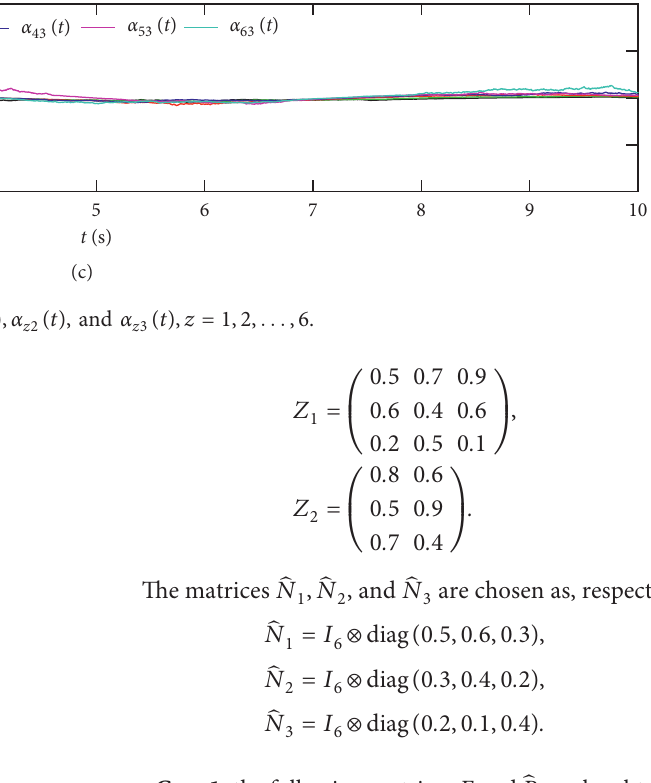
( t ) , α ( t ) , and α z 1 z 2